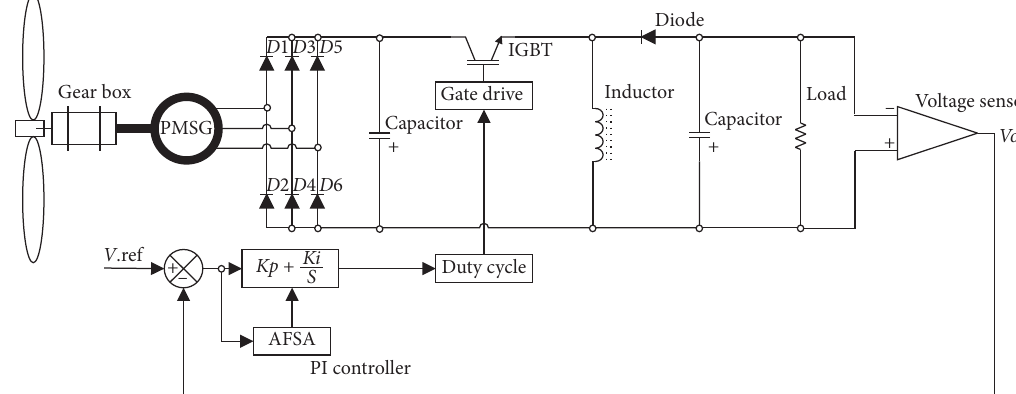
Figure 13: PI Control buck-boost converter based on wind turbine